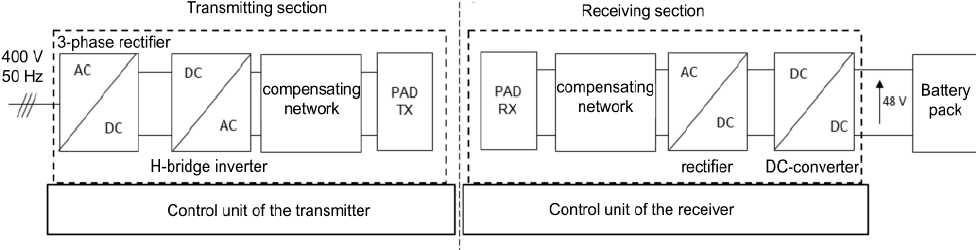
Figure 3. Block diagram of the IPT system. A communication link between the control units allows to control the transferred power.